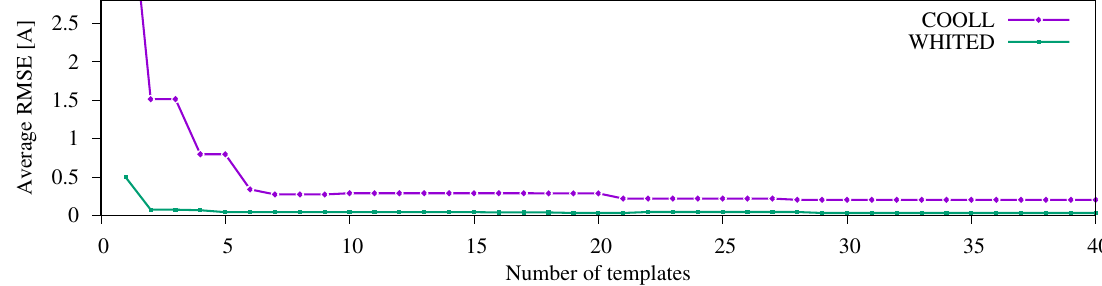
Figure 13. Resulting averaged RMSE versus the absolute number of templates used to represent the aggregation of COOLL data from two or three appliances